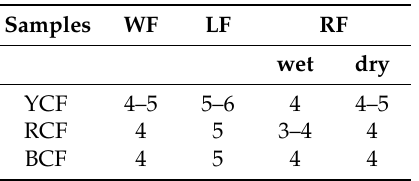
Table 2. Fastness properties of the colored